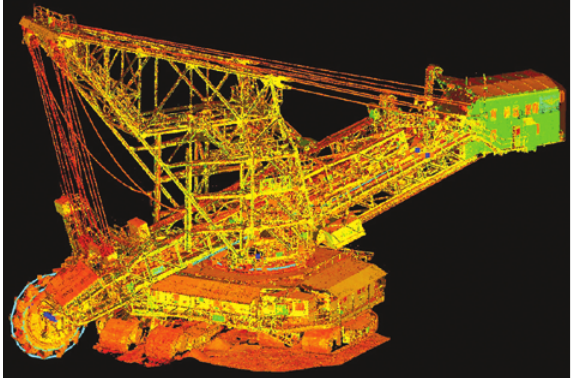
Fig. 3. Control point marks for ScanStation C10 and for Faro Focus 3D